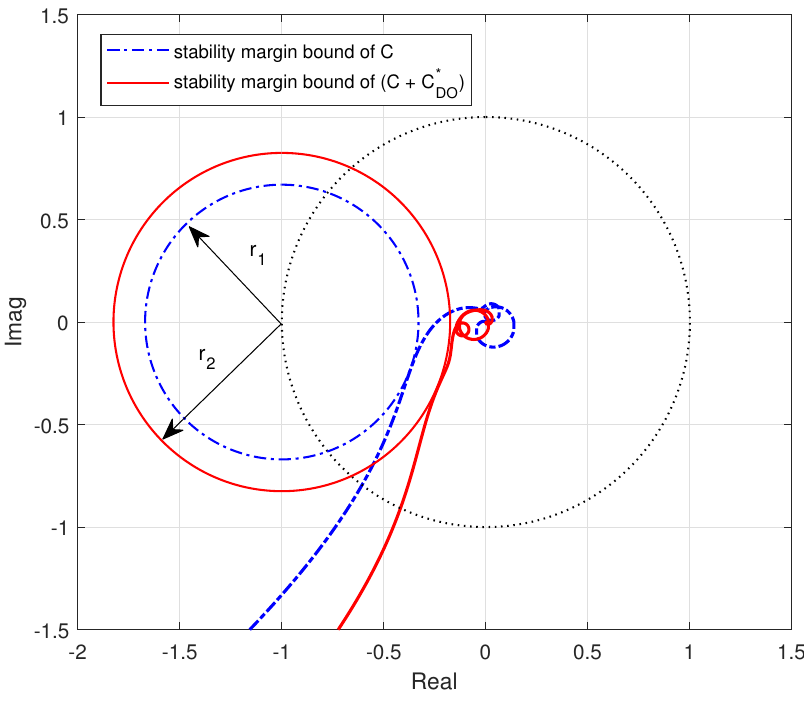
Figure 6. Nyquist plot and stability